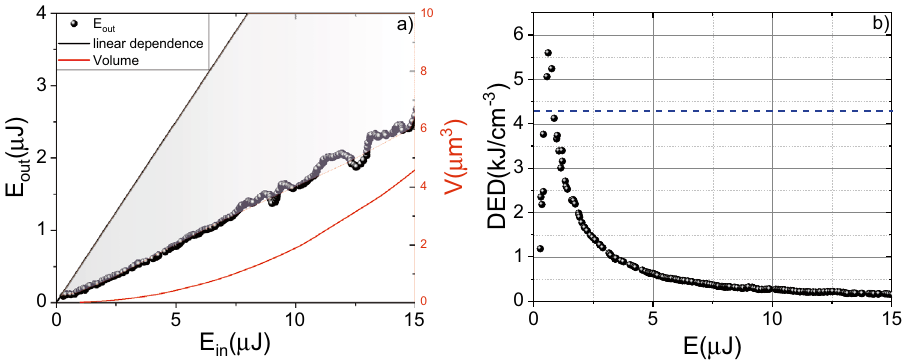
Figure 1. ( a ) Energy dependence of nonlinear transmission (black dots) and interaction volume (solid red line). The shaded area shows the absorbed energy region. ( b ) Dependence of DED on the laser pulse energy. The dotted line shows the threshold of micromodification